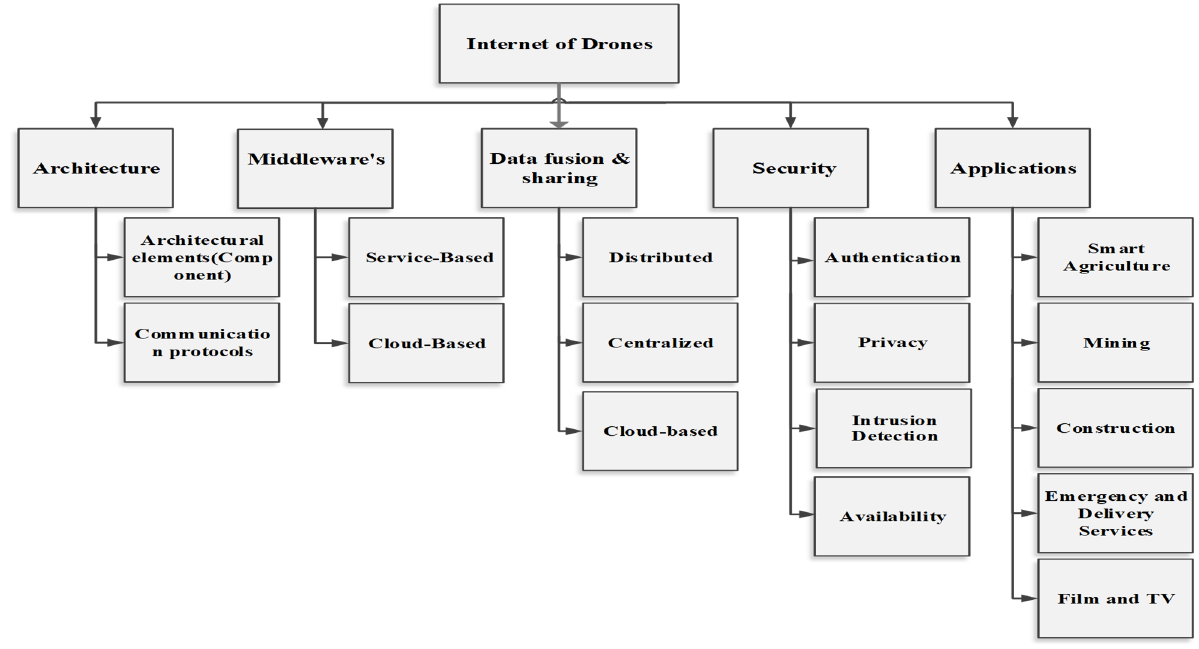
Figure 3. Taxonomy of IoD.